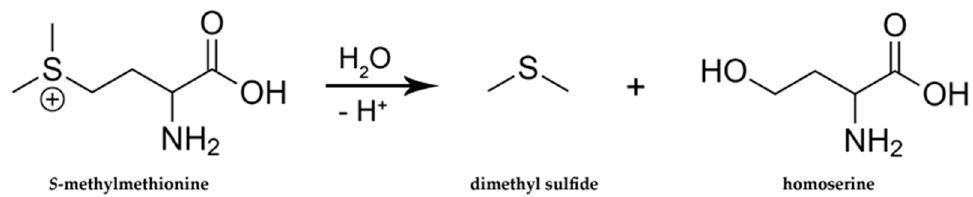
Figure 6. Thermal degradation of S-methylmethionine.